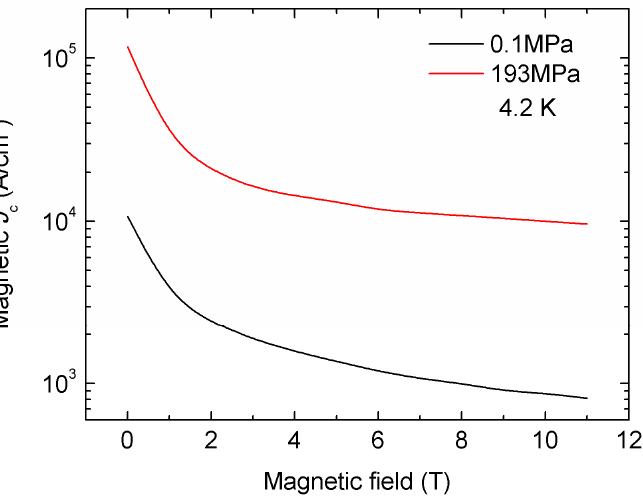
Figure 11. Magnetic J c of the (Ba,K)Fe 2 As 2 bulk samples heat-treated at 193 MPa and 0.1 MPa. Some data are based on [51].